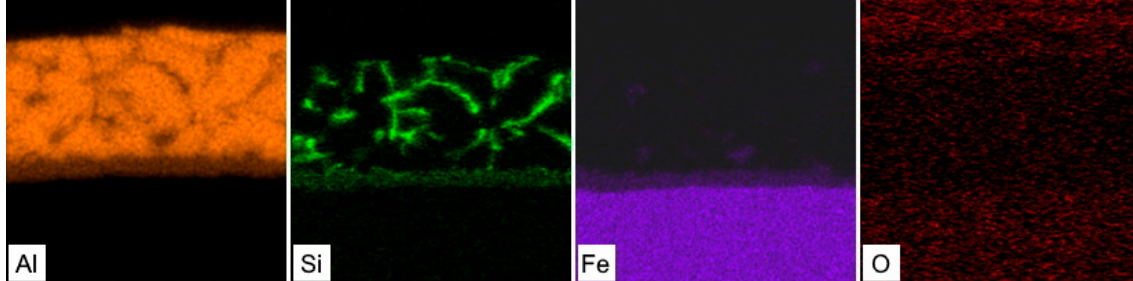
Figure 2. SEM-EDS elemental distribution maps of the Al-Si hot-dipped coating on as-received 22MnB5 boron steel.